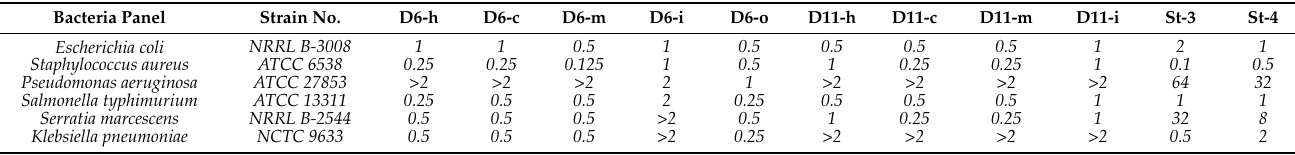
Table 4. Antibacterial effects of the samples (MIC, µ g/mL).